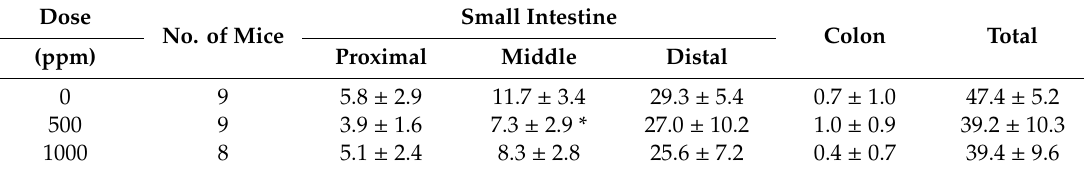
Data are presented as the means ± standard deviation (SD). Significantly different from the untreated control group at * p < 0.05.